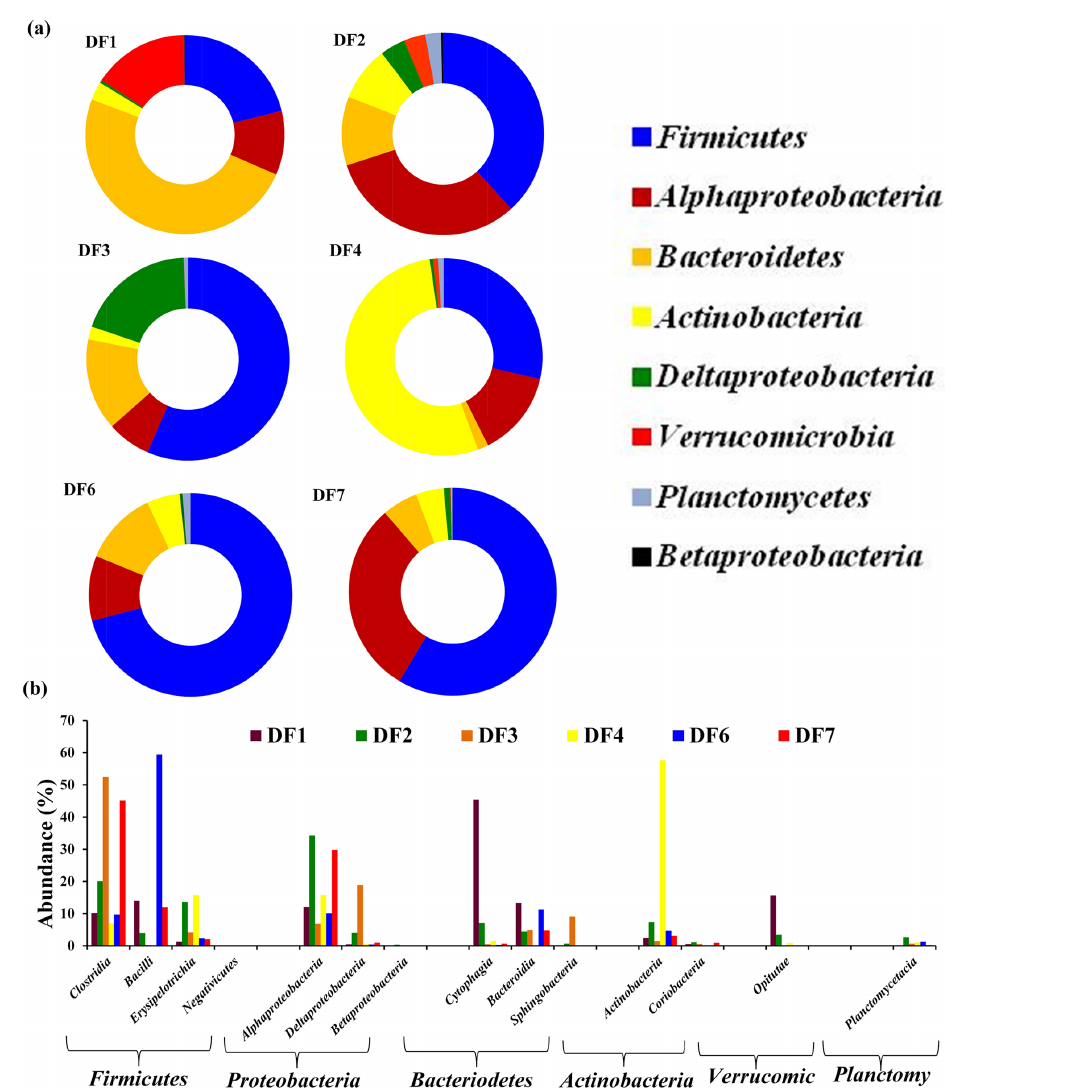
Figure 7. Microbial abundance of core OTUs at phylum (a) and class (b)